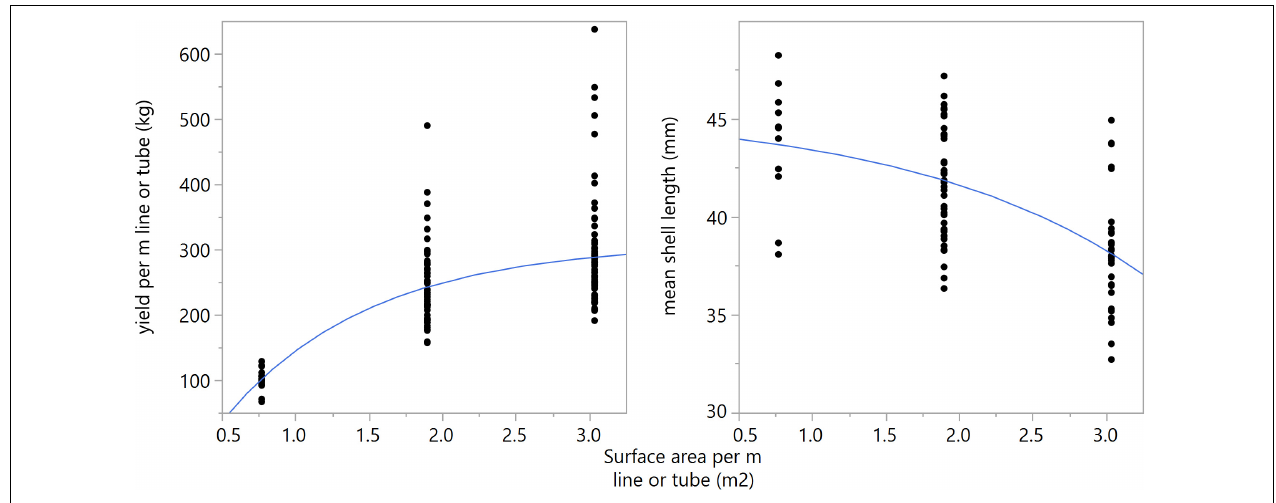
FIGURE 6 | Left panel: Biomass yield per m longline or tube (kg) regressed against substrate surface area (m 2 ) per m longline or tube at winter harvest [ y = 309.33–451.53eˆ(-1.005x)], ( R 2 = 0.48, p < 0.001). Right panel: Mean mussel shell length (mm) regressed against substrate surface area per meter line or tube